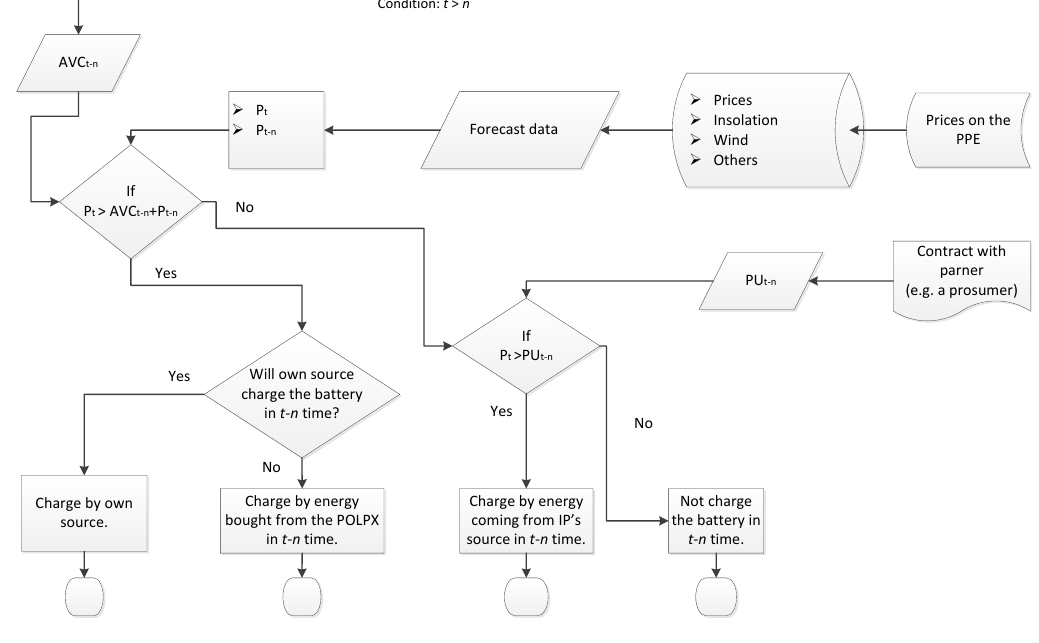
Figure 4. Battery-charging decision.